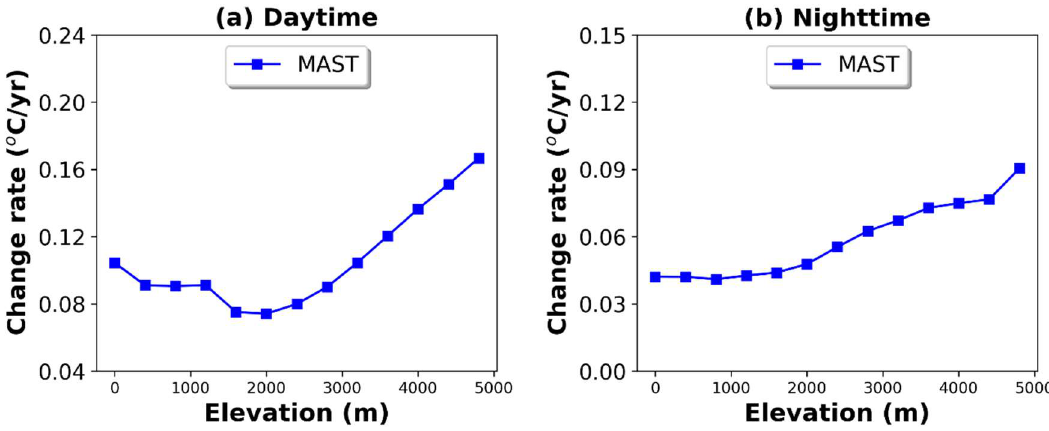
Figure 13. Distribution of the change rate of the daytime and nighttime MAST at different elevation